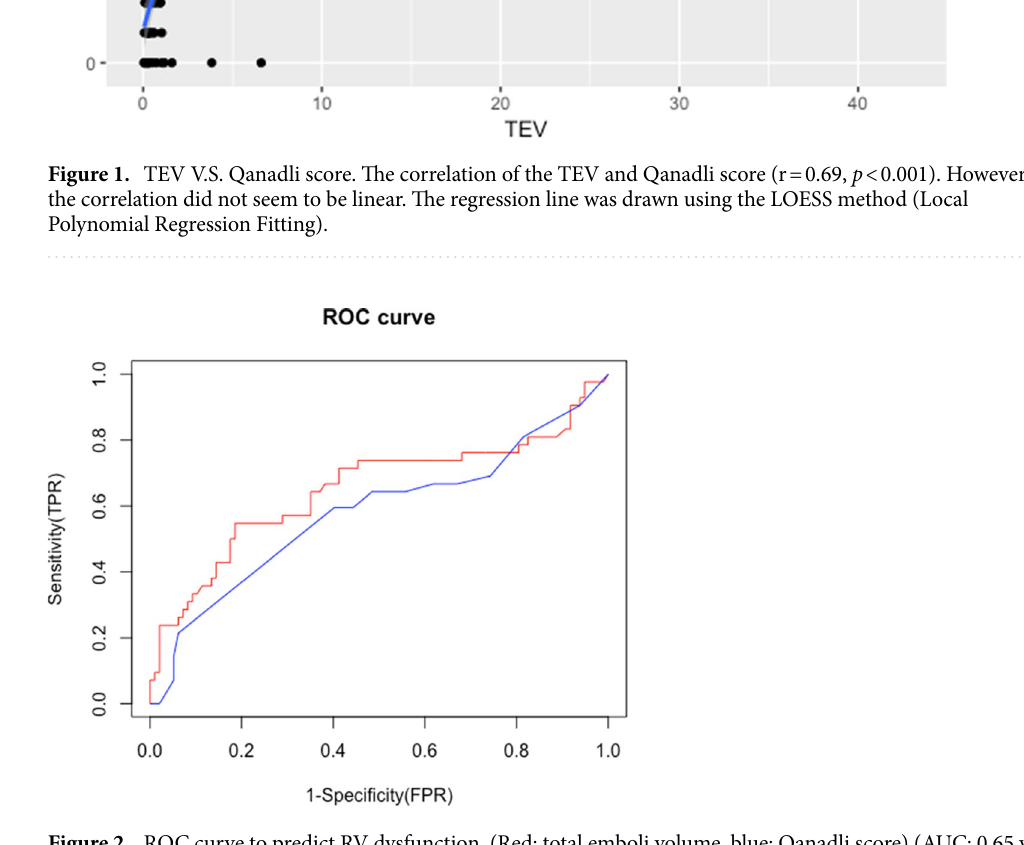
Figure 2. ROC curve to predict RV dysfunction. (Red: total emboli volume, blue: Qanadli score) (AUC: 0.65 vs. 0.58, p =